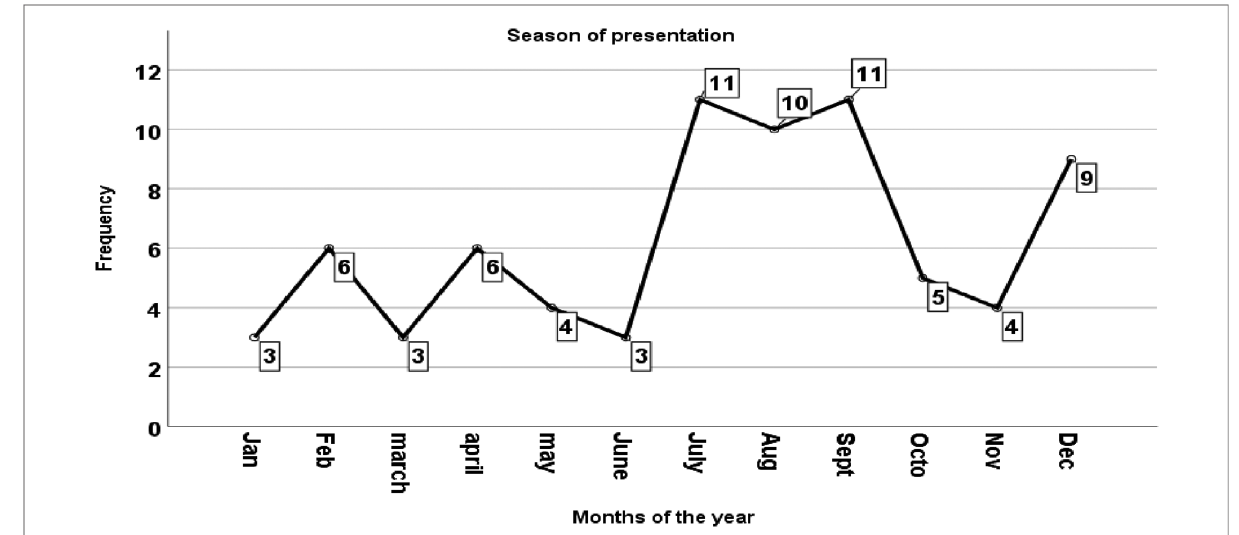
FIGURE 1 Distribution of acute intussusception presentation by months in a year among children admitted and managed for acute intussusception at HFSUH, Eastern Ethiopia, 2021 ( n =75).